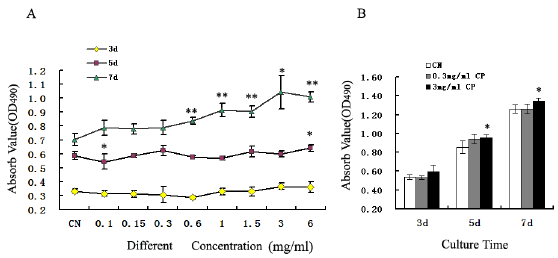
Figure 1. Effects of bovine CP compounds on the proliferation of MC3T3-E1 cells. The proliferation of MC3T3-E1 cells was measured by MTT assays after treatment with CP at 0.1–6 mg/mL (A) or 0.3 and 3 mg/mL (B) for 3–7 days. Data are expressed as means 6 standard deviation ( n =6). * p , 0.05, ** p , 0.01, Significant difference from CN. CP: bovine collagen peptides compounds; CN: